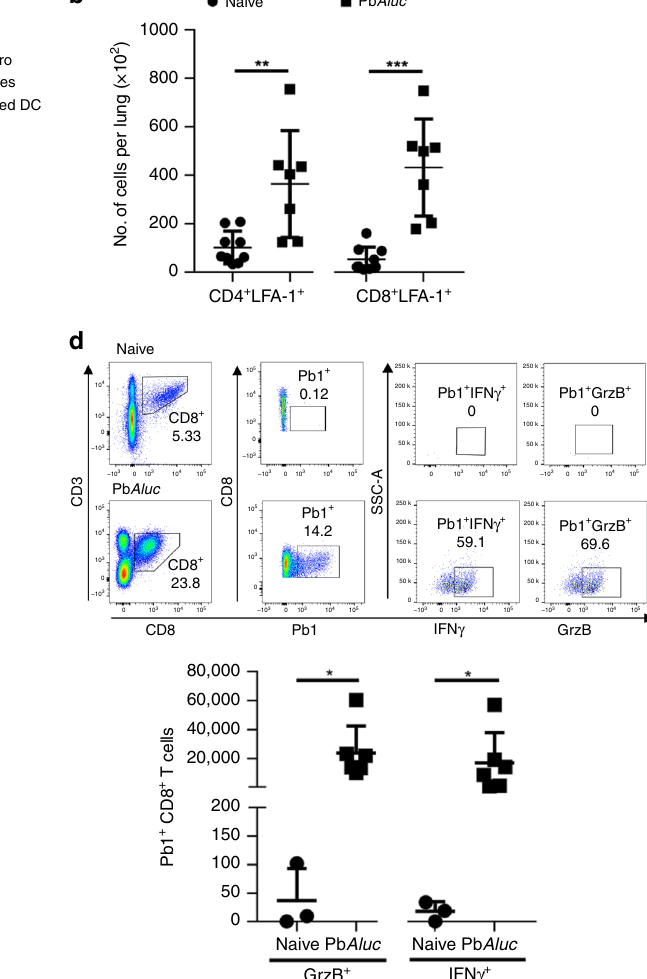
(Fig. 4d, right panel). When comparing the pathological scores, we found that untreated PbA luc -infected mice had a higher total score than treated PbA luc -infected mice (Fig. 4e). Quanti fi cation of the pathological scores con fi rmed that anti-CD8 β antibody treatment signi fi cantly diminished pulmonary edema (Fig. 4f) and intra-alveolar erythrocyte extravasation (Fig. 4g) when compared to untreated PbA luc -infected mice. Because we observed substantial pulmonary vascular leakage in PbA luc -infected mice, we next sought to investigate whether the damage extended to the pulmonary epithelium and if so, whether CD8 + T-cell depletion could also prevent damage to the epithelium wall. Here, we performed immuno fl uorescence on paraf fi n-embedded lung sections using antibodies against E- cadherin and zonula occludens 1 (ZO-1) proteins to identify epithelial cells and tight junctions, respectively (Fig. 4h). Based on the average intensity of ZO-1 signal, we found that ALI was also